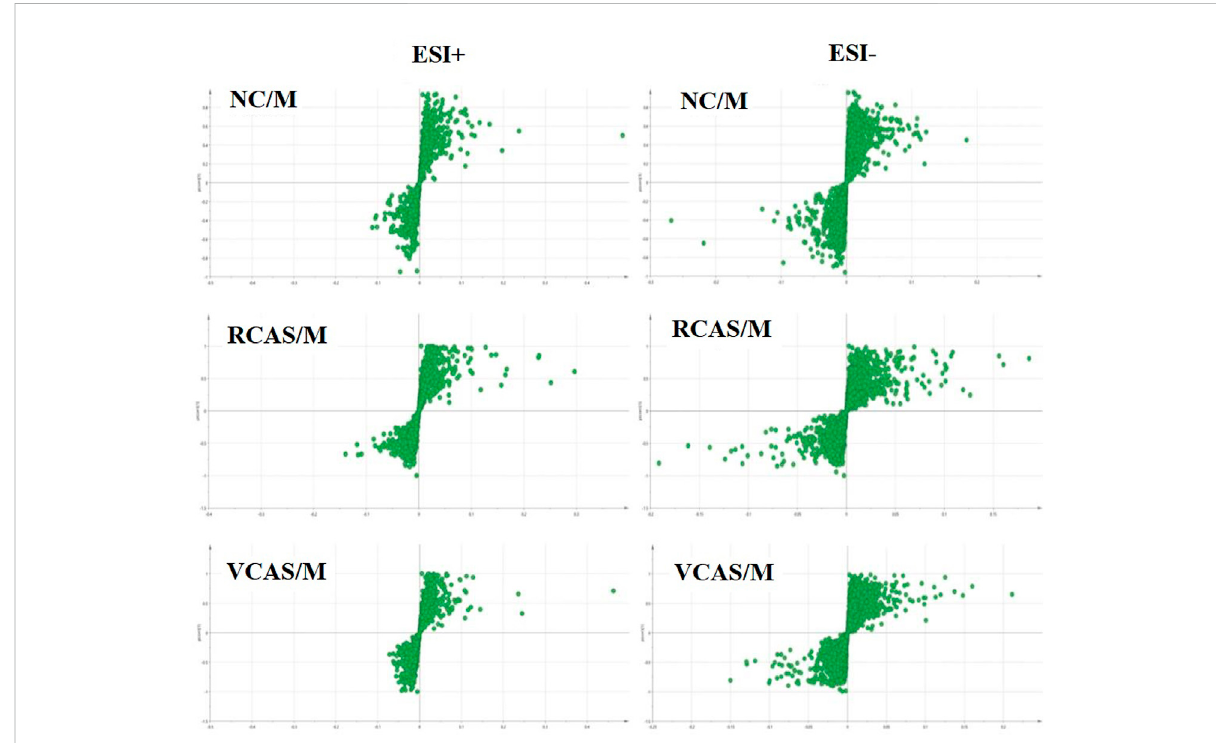
FIGURE 4 S-plot from plasma samples in the positive and negative ion mode.